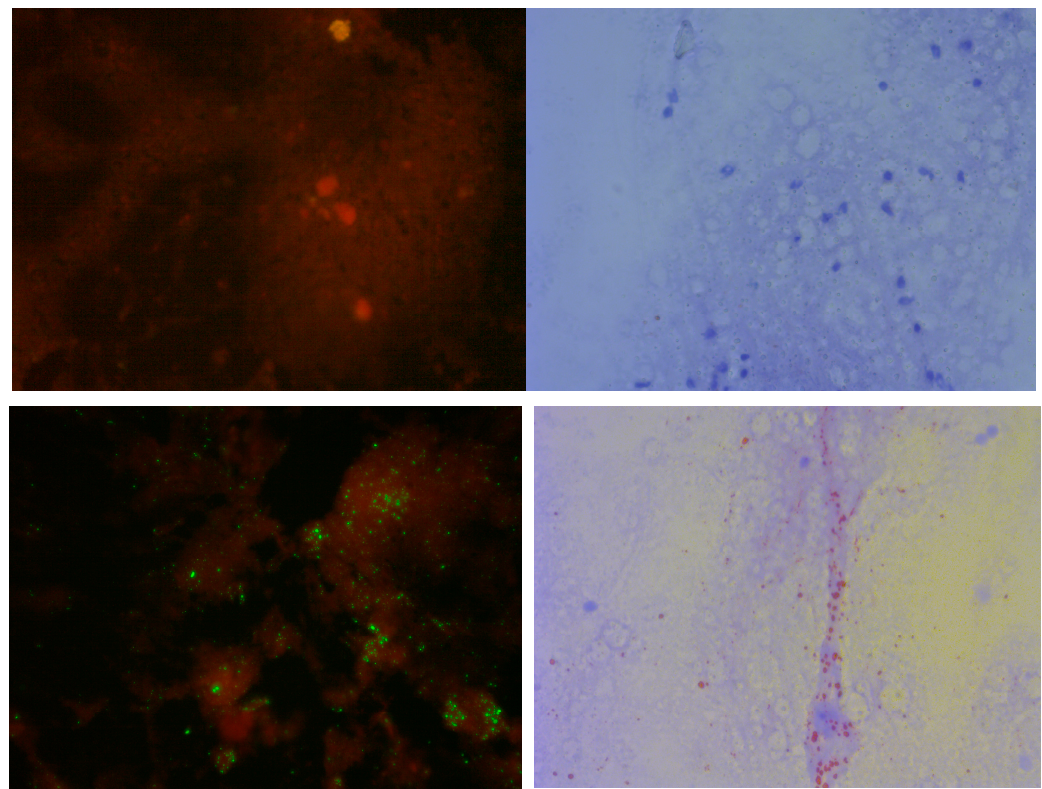
Figure 1. Brain impression from a non-rabid dog ( top two panels ) or a dog suspected of rabies ( bottom two panels ), subjected to direct fluorescent antibody (DFA) test using anti-rabies virus nucleocapsid protein IgG-FITC conjugate ( left two panels ) or to direct rapid immunochemistry test with (dRIT) using biotinylated mouse anti-rabies monoclonal antibodies and streptavidin-peroxidase, with hematoxylin couterstain ( right two panels ). Scale: 200×.